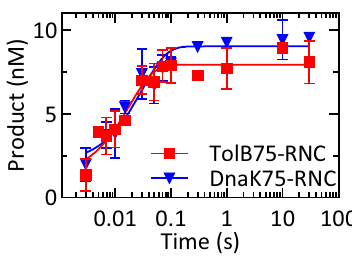
Figure 2. Pre-steady-state kinetics of RNC deformylation. DnaK75-RNC or TolB75-RNC (10 nM final concentration) were rapidly mixed with PDF at saturating concentration (25 µM) in a quench-flow apparatus at 37 °C. At the indicated times, samples were quenched, treated with PK, and analyzed by TLC (“Materials and methods”). Time courses were evaluated by fitting to a single-exponential function, yielding an apparent rate constant k app (37 °C) = (48 ± 9) s −1 . Error margins represent the standard deviation of three independent